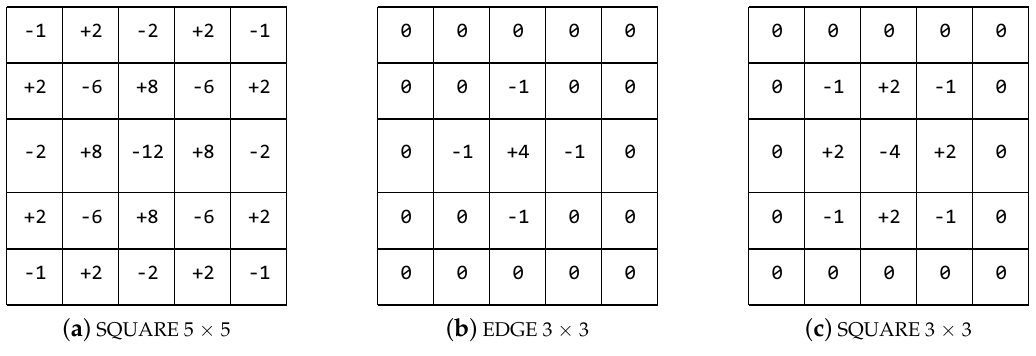
Figure 2. Three high-pass filter (HPFs) used in the proposed method. ( a ) the high-pass filter of SQUARE 5 × 5, ( b ) the high-pass filter of EDGE 3 × 3, ( c ) the high-pass filter of SQUARE 3 ×